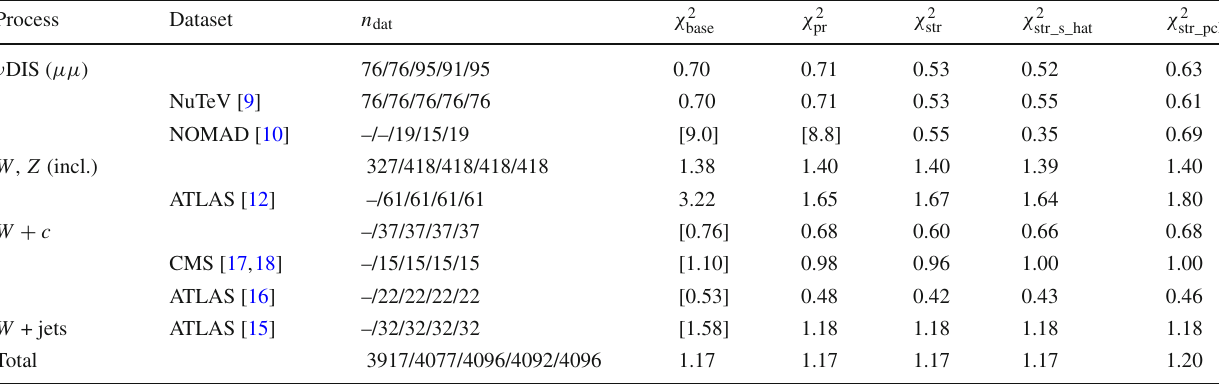
Table 2 Values of χ 2 per data point for the strangeness-sensitive datasets discussed in this work obtained from the str_base , str_prior , str , str_s_hat , and str_pch fits; see Table 1. Values in square brackets are for datasets not included in the corresponding fit Process